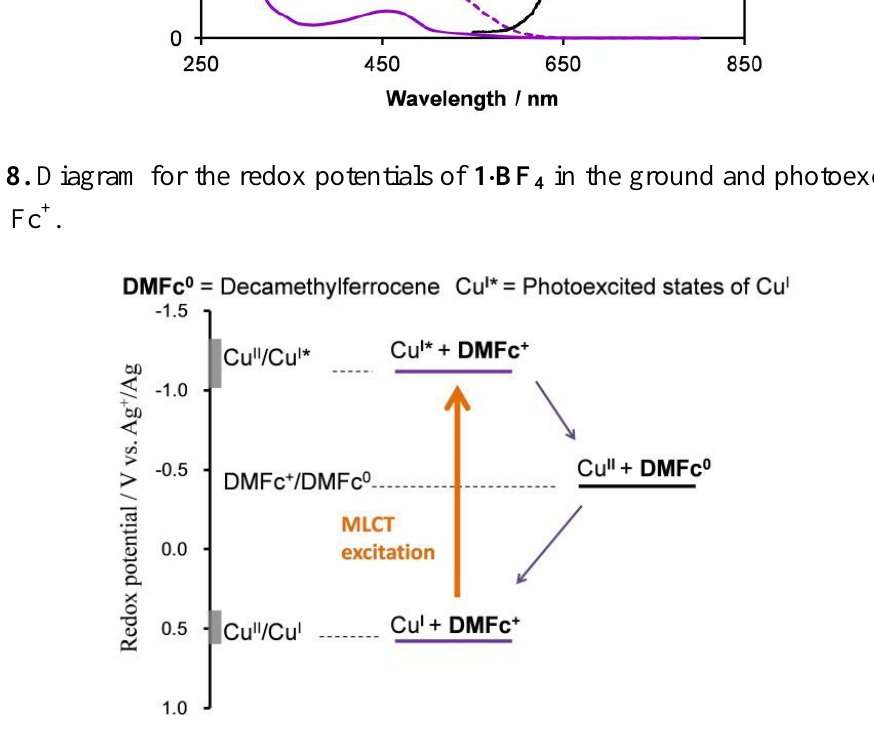
in the ground and photoexcited states, 4